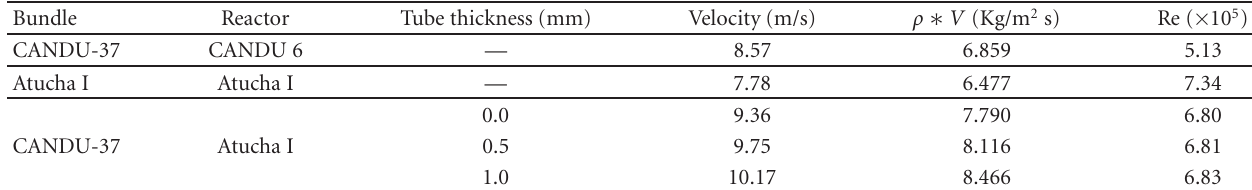
Table 7: Flow excitation parameters in both reactors.